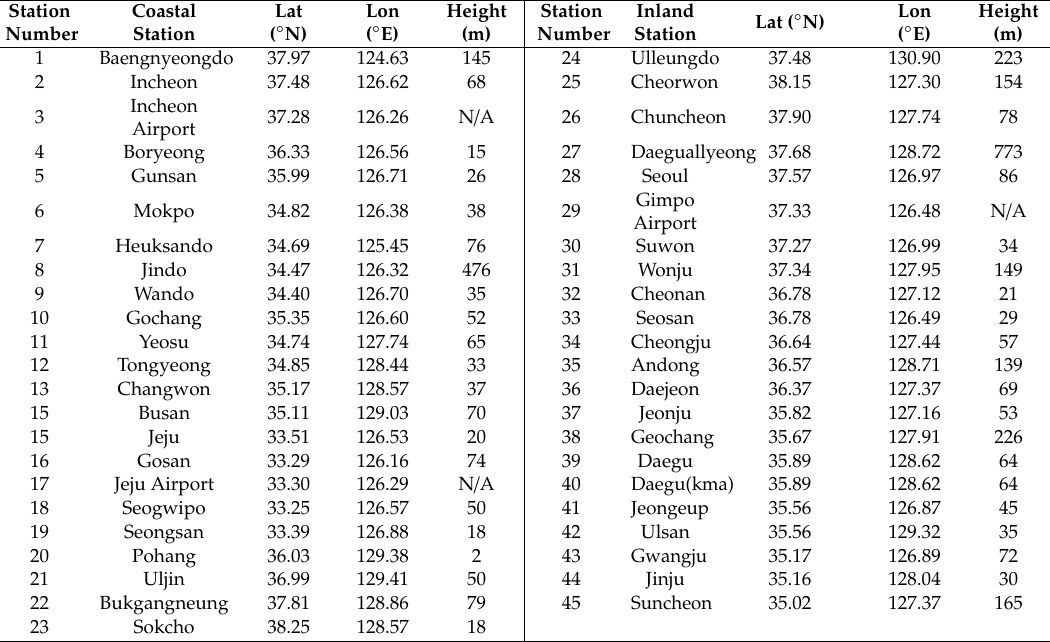
Table A2. The 45 meteorological stations in South Korea used in the LSF analysis.